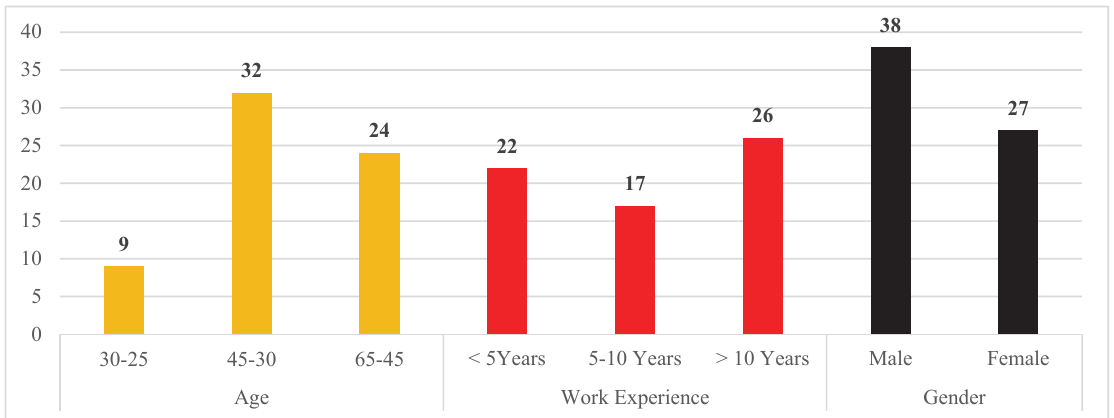
Fig. 2. The demographic features of participant retailers